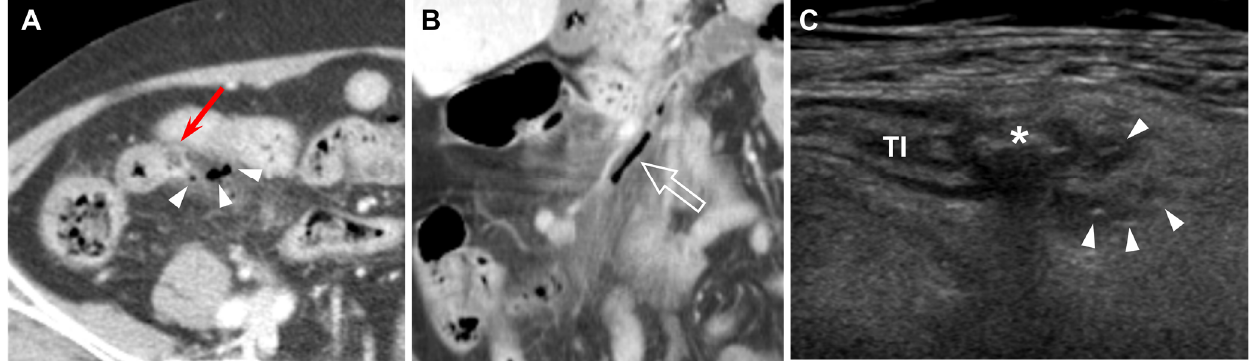
Figure 4. Sixty-three-year-old female (patient #9) with acute perforated ileal diverticulitis. ( A , B ) Axial and coronal reformatted CT scans show inflamed diverticulum (red arrow), with extraluminal gas (arrowheads) representing perforation. Mesenteric fat infiltration, terminal ileal wall thickening, and mesenteric venous gas (open arrow) are also seen. ( C ) US scan demonstrates an outpouching inflamed diverticulum with central hyperechoic fecalith (*) connecting to terminal ileum (TI), and tiny hyperechoic reverberating dots (arrowheads) represent extraluminal air bubbles.